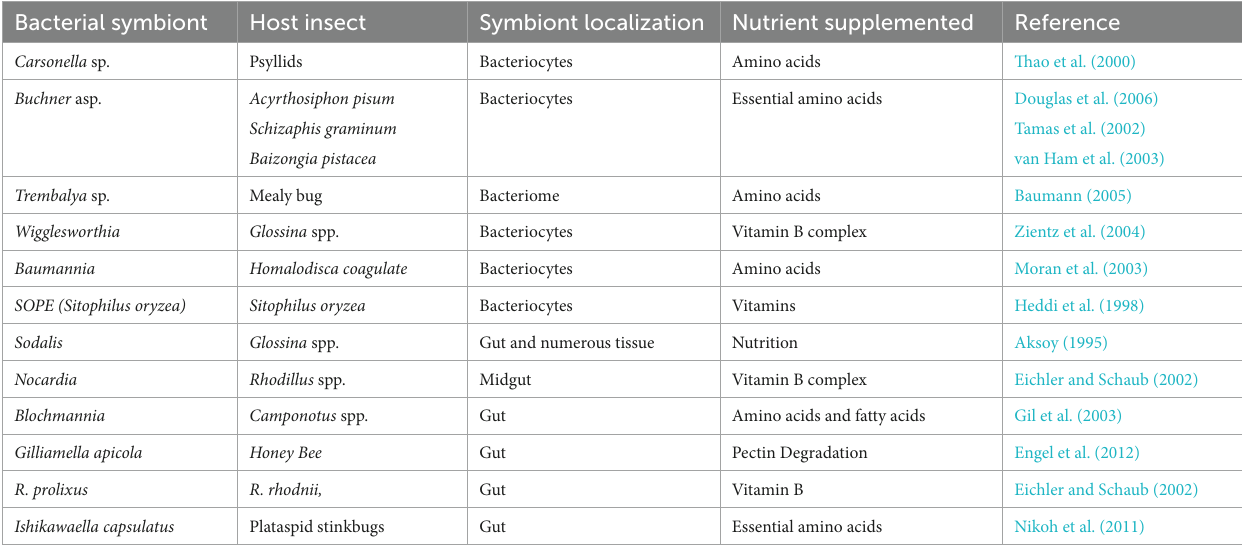
TABLE 1 List of symbionts helpful in